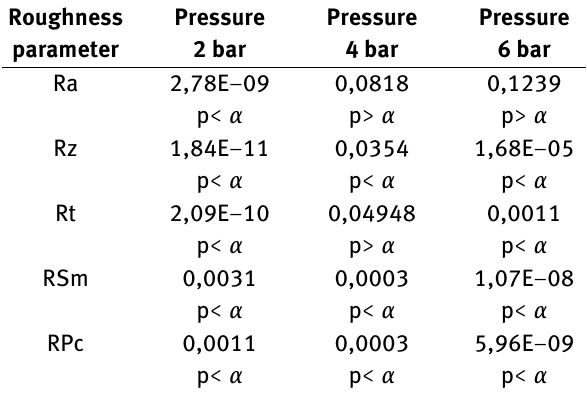
Table 8: p-values at different